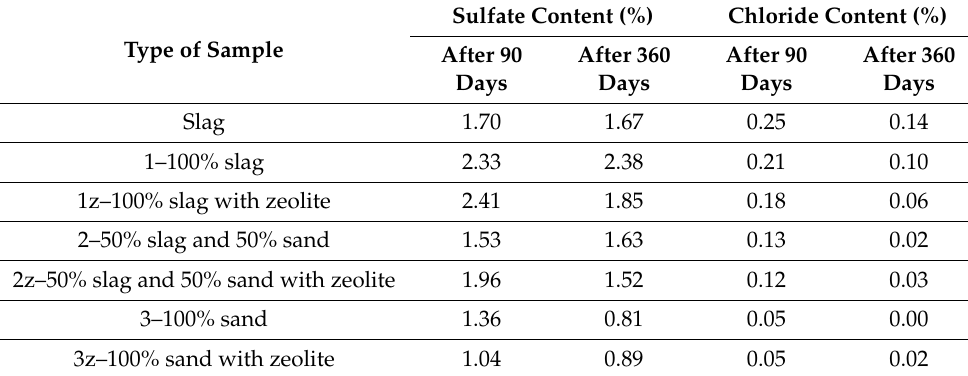
Chloride and sulfate content was determined for slag and all samples after 90 and 360 days. The results of the determinations are presented in Table 6. Table 6. Chloride and sulfate content in slag and cement mortars with different replacement of sand by MSWI